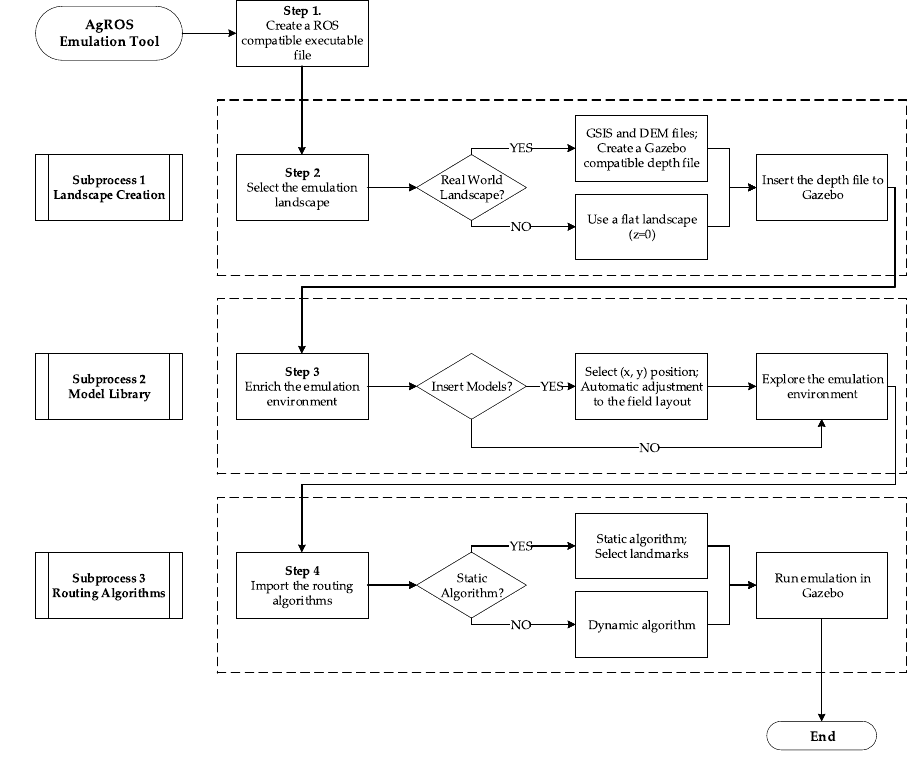
Figure 3. AgROS workflow.